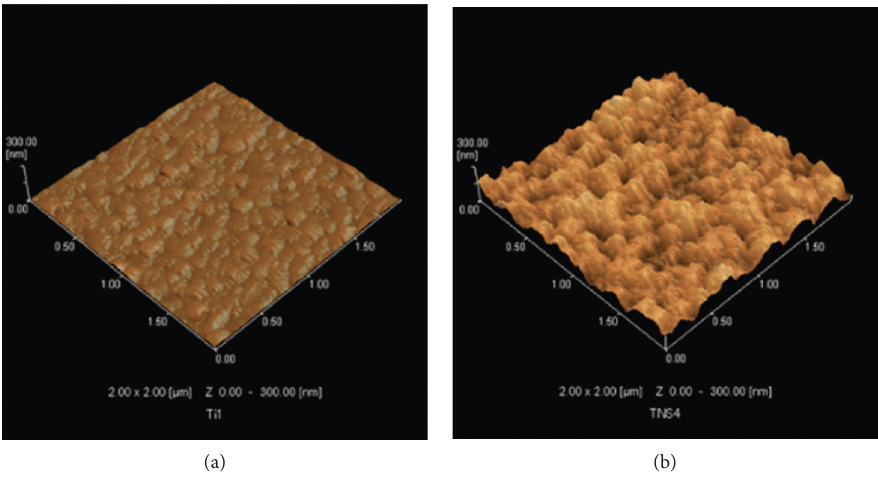
Figure 2: SPM images of (a) Ti and (b) TNS QCM